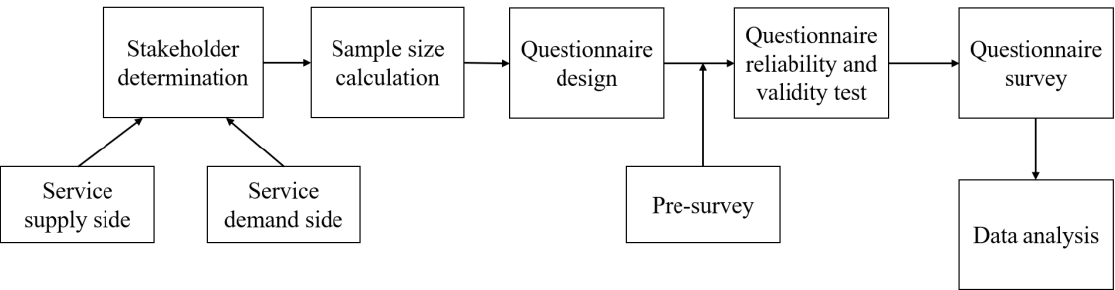
Figure 2. Research procedure of the quantitative research.